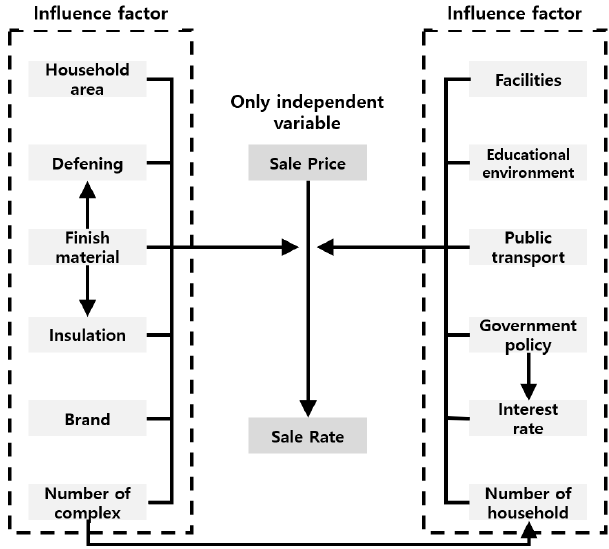
Figure 3. Basic postulate of this study.